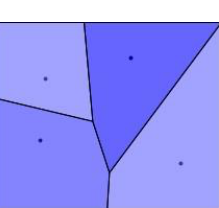
Figure 2. Voronoi diagram for geographic data. The bounding box is not appropriate for this irregularly spread data. It makes 2 The Dutch dialect data in Figures 2, 3 and 6 are an aggregated version of the data in the SAND database (Barbiers et al,